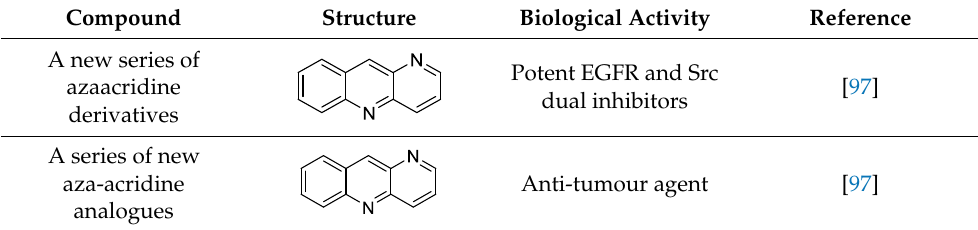
Table 16. Some of the most potent compounds and their IC 50 (micromolar) values with cell lines. Cancer Cell Potent Compound